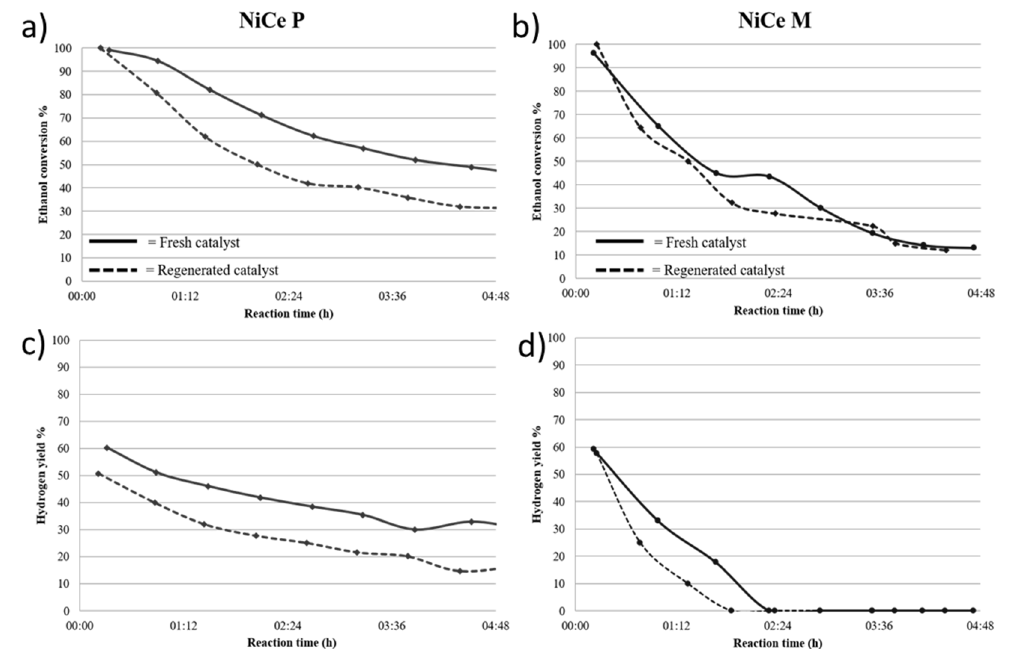
Figure 9. Ethanol steam reforming on fresh (solid lines) and reactivated (dotted lines) catalysts. Ethanol conversion ( a ) NiCe P and ( b ) NiCe M and hydrogen yield ( c ) NiCe P and ( d ) NiCe M vs. reaction time.